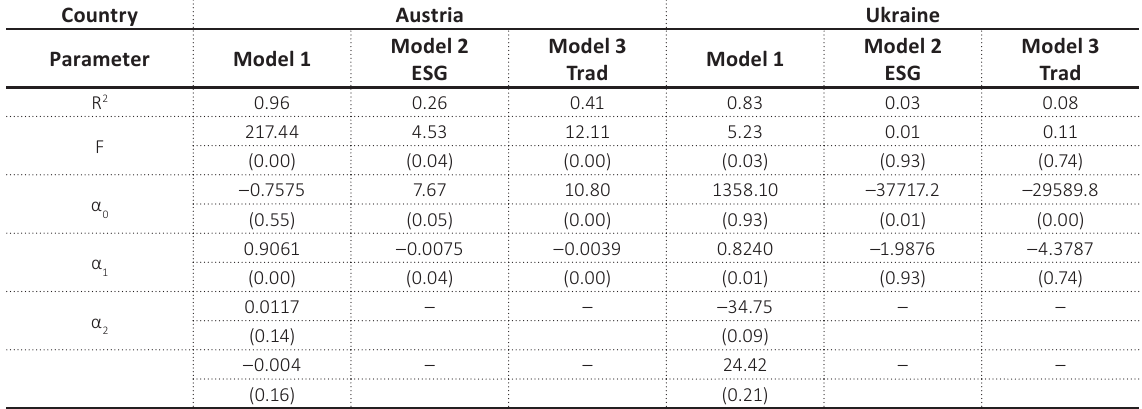
Table 7. Regression modelling of the investment position: the case of Ukraine and Austria Country